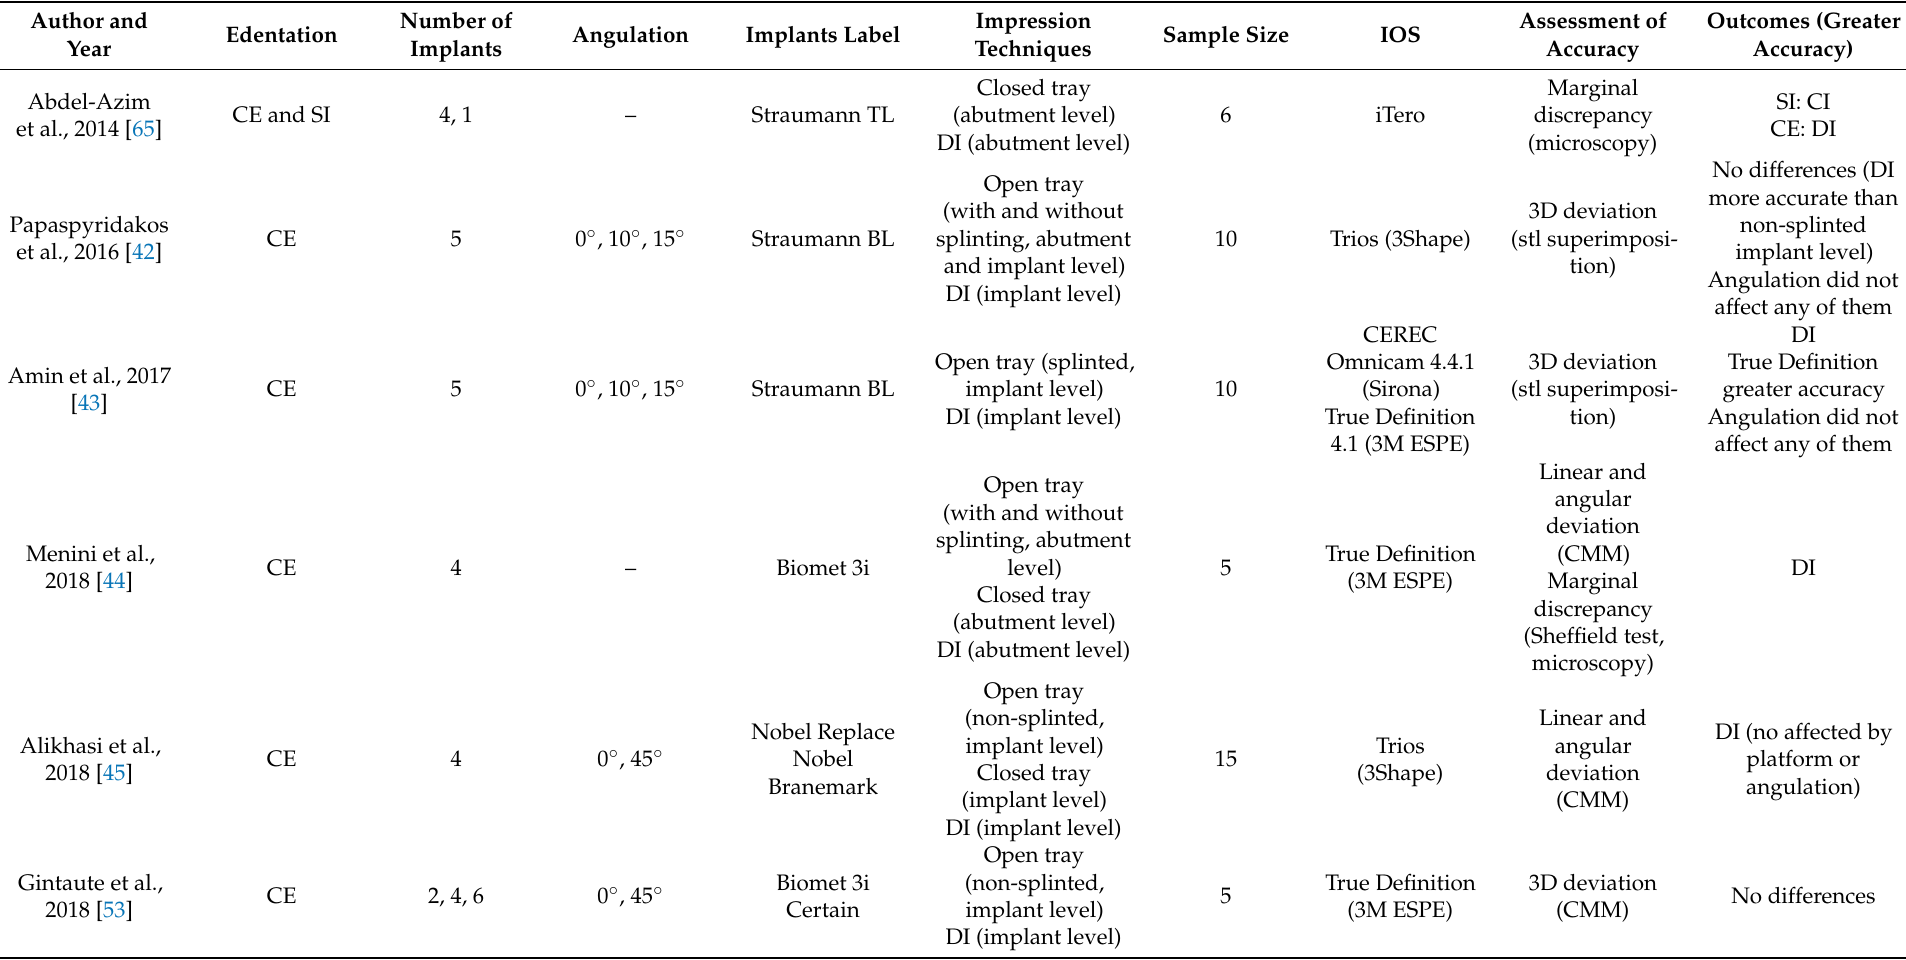
Table 3. Summary of selected